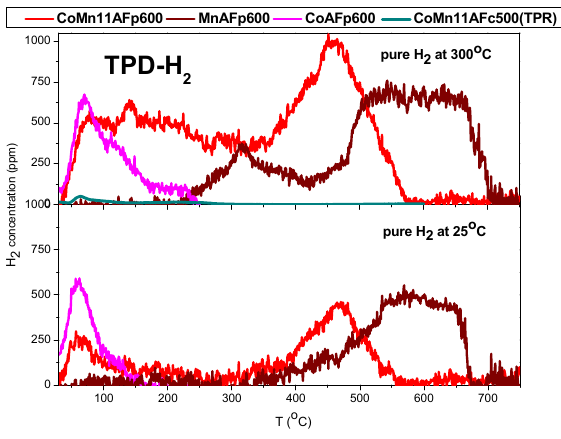
Figure 3. H 2 ‐ TPD profiles following its adsorption at 25 °C and 300 °C on CoMn11AFp600, CoAFp600, MnAFp600 and CoMn11AFc500 (TPR) samples. Table 1. Amounts of hydrogen desorbed during TPD after adsorption at 25 and 300 °C .